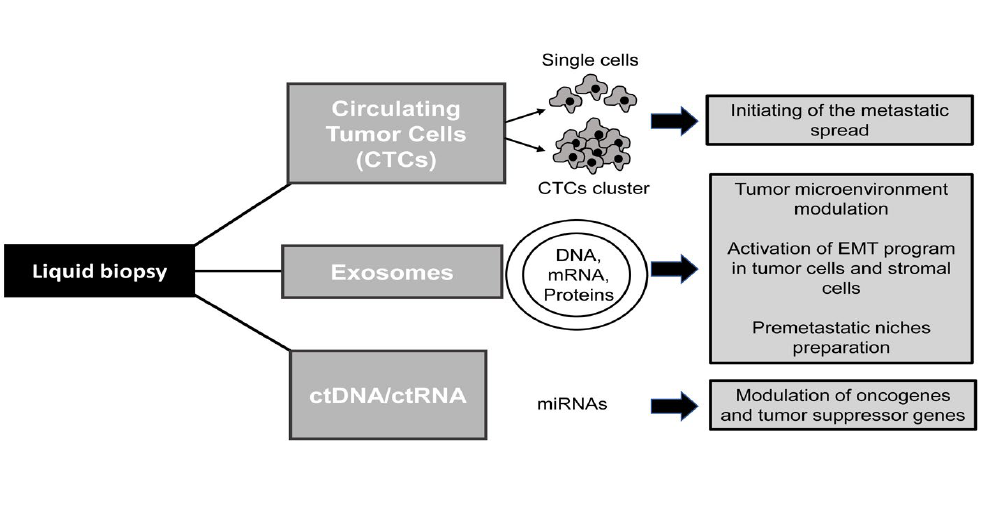
Figure 1. Role of tumor-derived components in cancer